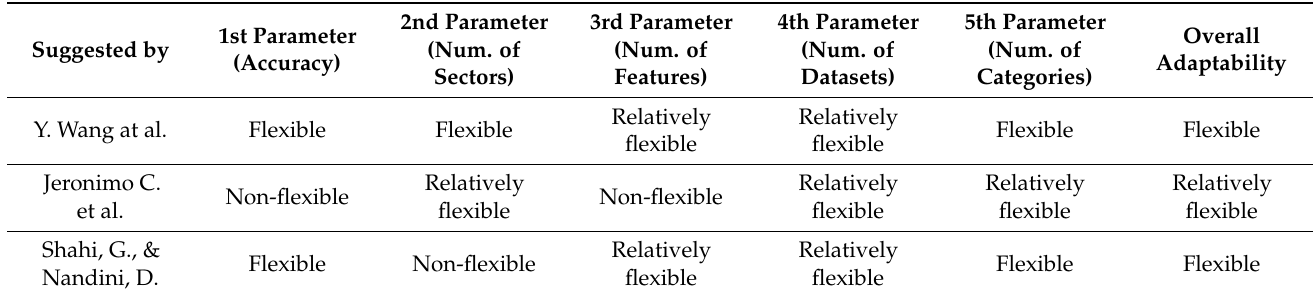
Table 19. Adaptability of Multi-Cross